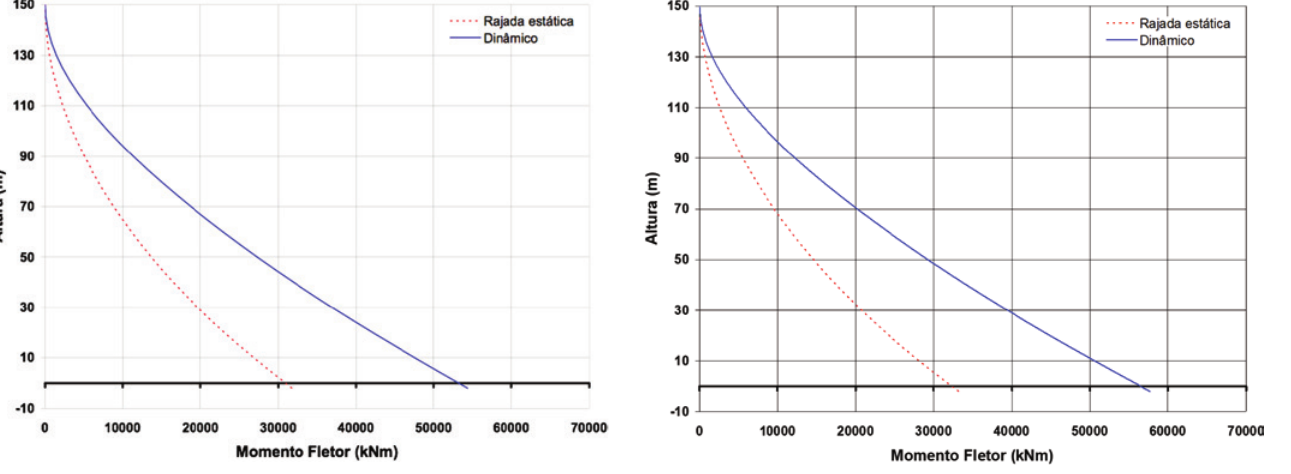
Comparison between the static gust method and the dynamic method for the isolated chimney with code aerodynamic coefficients